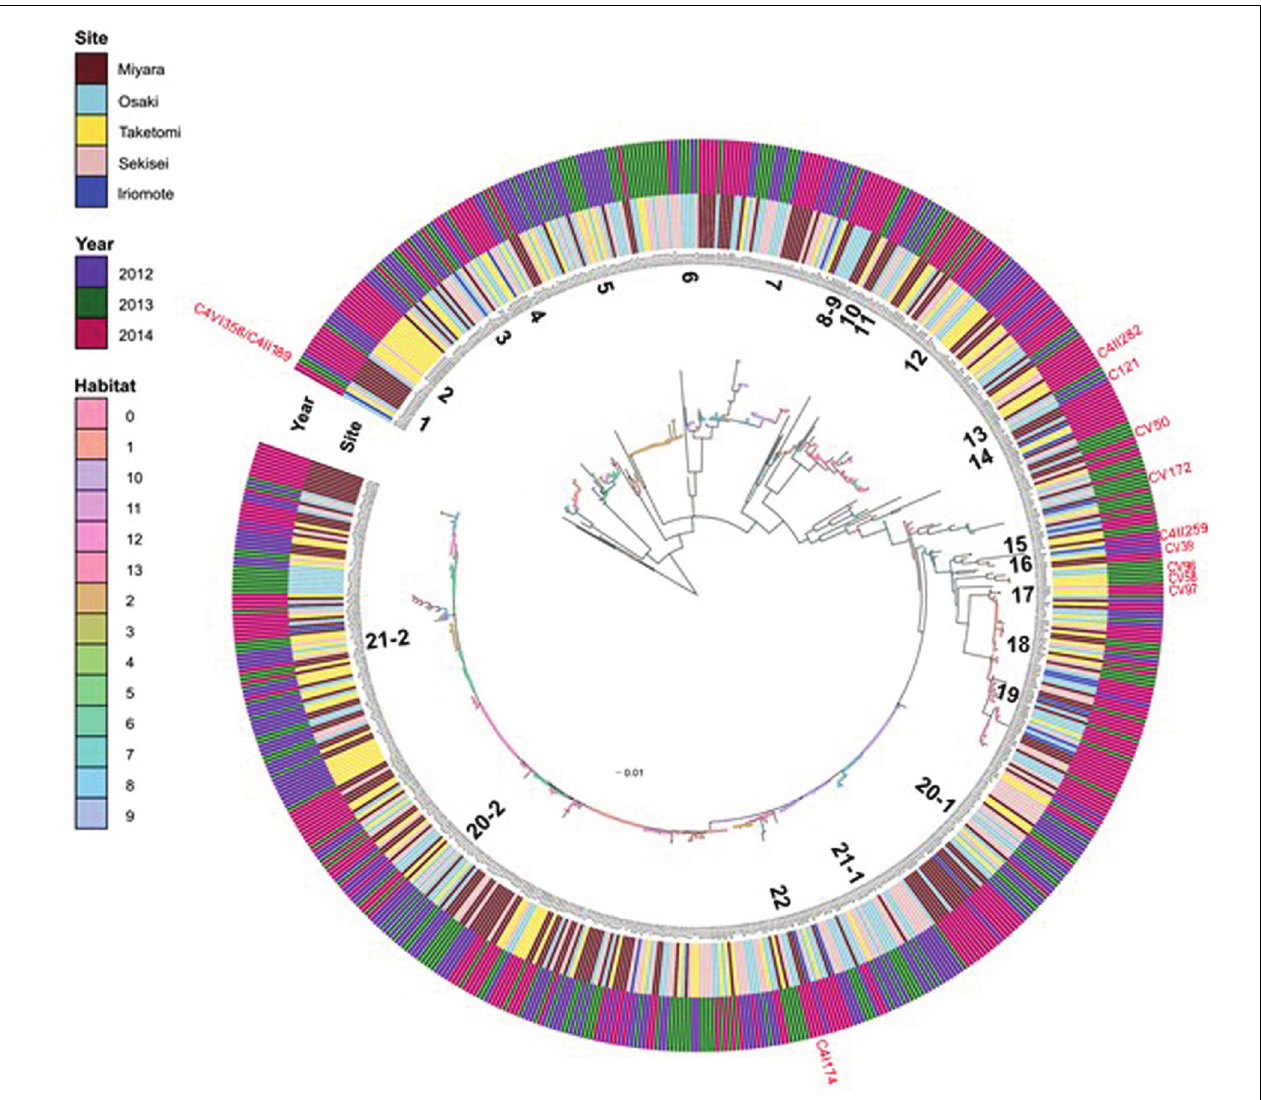
FIGURE 2 | Inferred habitats predicted by AdaptML model using pyrH gene sequences of Vibrio isolates from Ishigaki coral reef seawater. Inner and outer ring indicate sampling sites and sampling years respectively. Predicted habitats are shown as nodes on the tree (habitat legend matches the colored circles). The closest named Vibrio species to numbered Vibrio populations’ are as follows- (1) P. aphoticum ; (2) V. astriarenae ; (3) V. ishigakensis ; (4) V. pelagius ; (5) P. rosenbergii ; (6) V. mediterranei ; (7) V. variabillis/maritimus ; (8) V. nigripulchritudo ; (9) V. orientalis ; (10) V. tubiashii ; (11) V. alginolyticus ; (12) V. coralliilyticus/neptunis ; (13) V. ponticus ; (14) V. azurius ; (15) V. alfacsensis ; (16) V. orientalis ; (17) P. damsella subsp. piscicida ; (18) V. harveyi ; (19) V. campbellii ; (20-1) V. owensii- 1; (20-2) V. owensii -2; (21-1) V. hyugaensis ; (21-2) V. hyugaensis ; (22) V. communis . Red marked strains, outside of the outer ring indicate the positions of putative new species